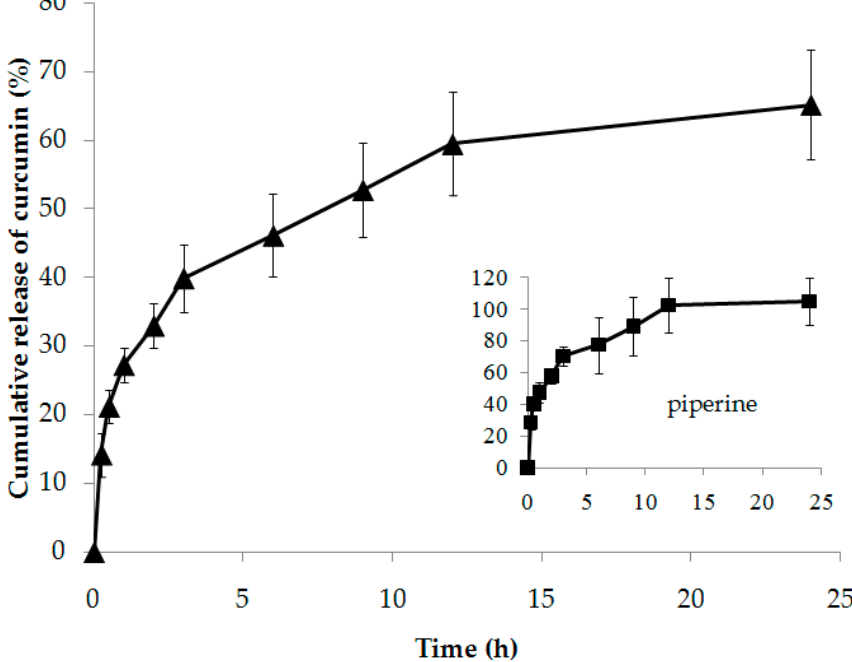
Figure 6. Release profiles of curcumin and piperine from composite membrane (CM200:8) in PBS pH 7.4 at 37 ± 1 °C.